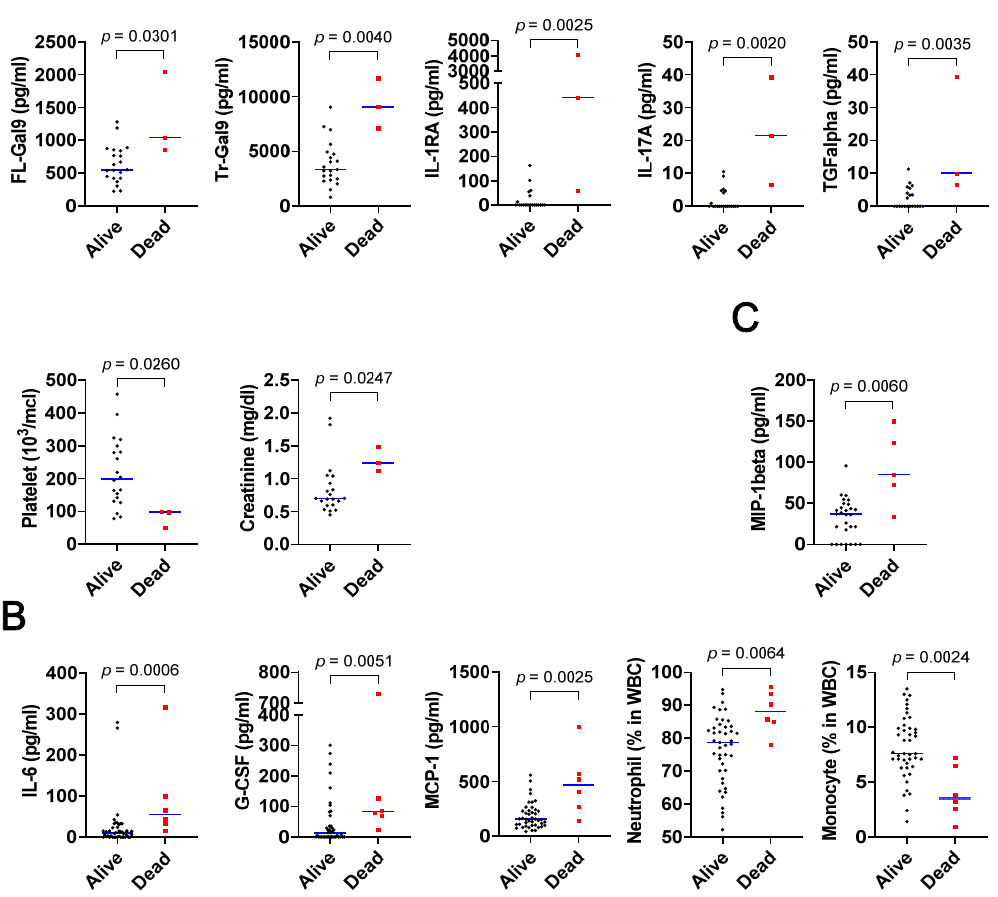
Figure 5. Molecules whose AUC values are > 0.8 and p < 0.05 in deceased patients, compared with survivors. AIDS ( A ), TB ( B ), and AIDS/TB patients ( C ).